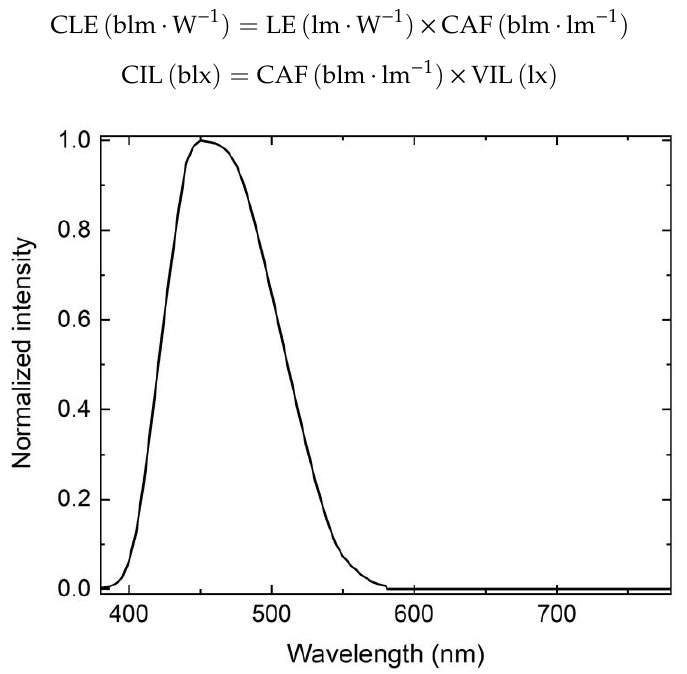
Figure 1. Circadian action spectrum. Data replotted from [14].